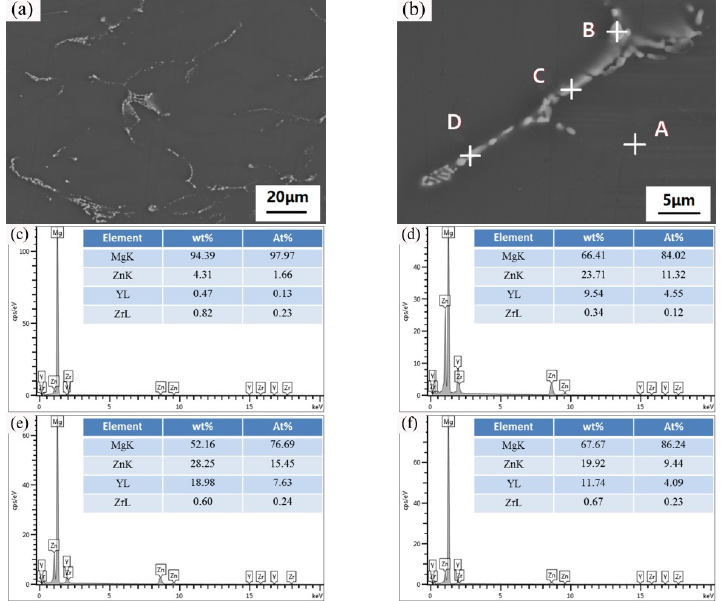
Figure 16. SEM microstructure ( a ), ( b ), and EDS analysis of the samples after 520 °C—1 h heat treatment: ( c ) Spot A, ( d ) Spot B, ( e ) Spot C, ( f ) Spot D. Table 9. Atom ratios (at%) for different elements of each spot in Figure 16b.